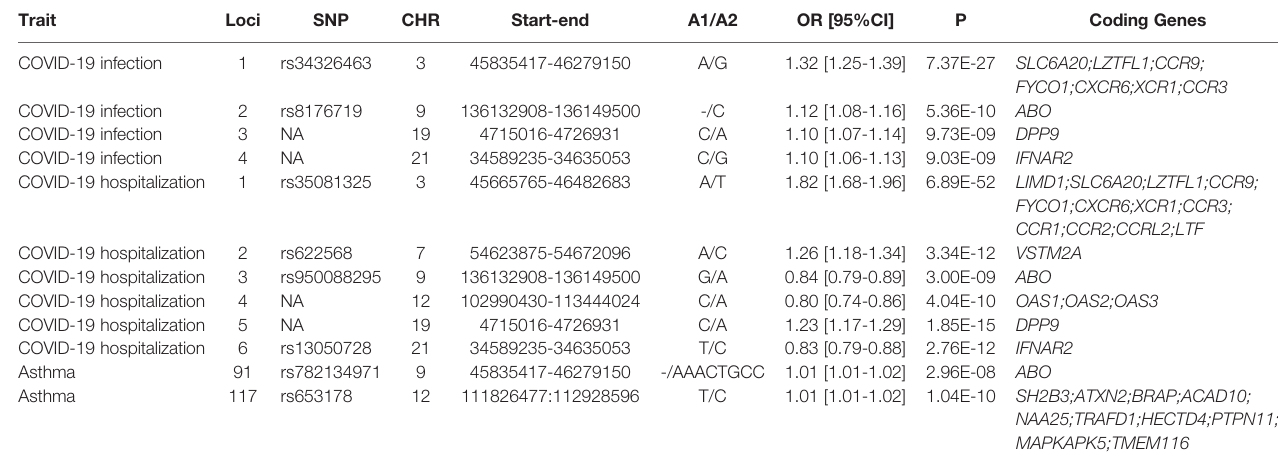
TABLE 2 | Genomic loci in fl uencing the COVID-19 outcomes and asthma.